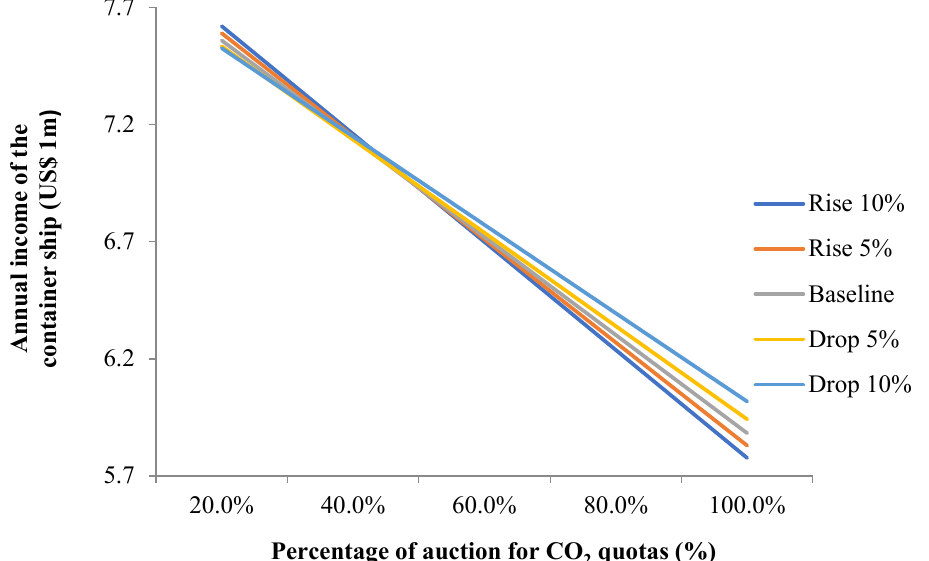
Figure 5. Volatility graph of the auction and purchase prices of carbon. Table 10. Sensitivity analysis of incentive